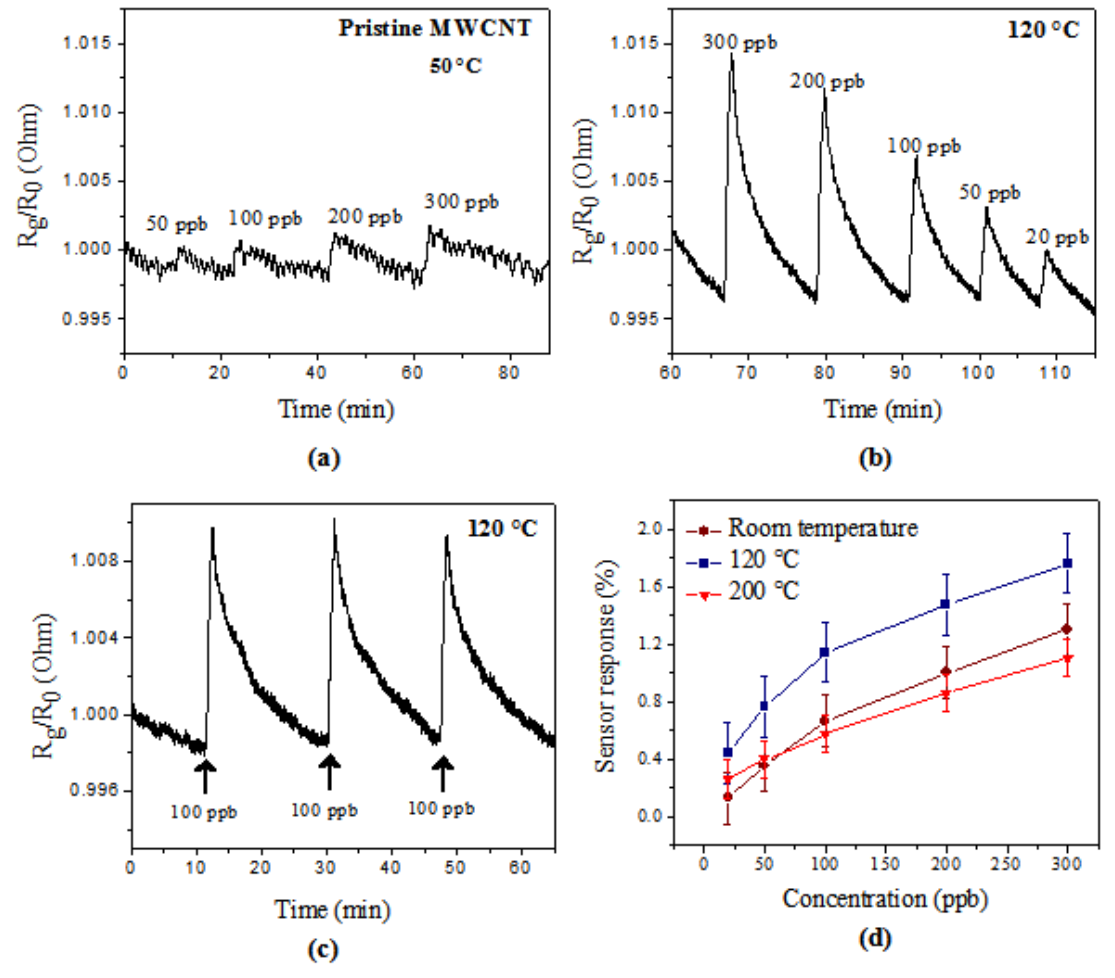
Figure 5. Electrical resistance change of sensors in the presence of O MWCNT tested at 50 °C with different concentrations; ( b ) MWCNT-Pd evaluation at different concentrations in the range 20 to 300 ppb; ( c ) repeatability of response sensor MWCNT-Pd at 100 ppb; and ( d ) comparison of the calibration curves at different MWCNT-Pd sensor temperatures.